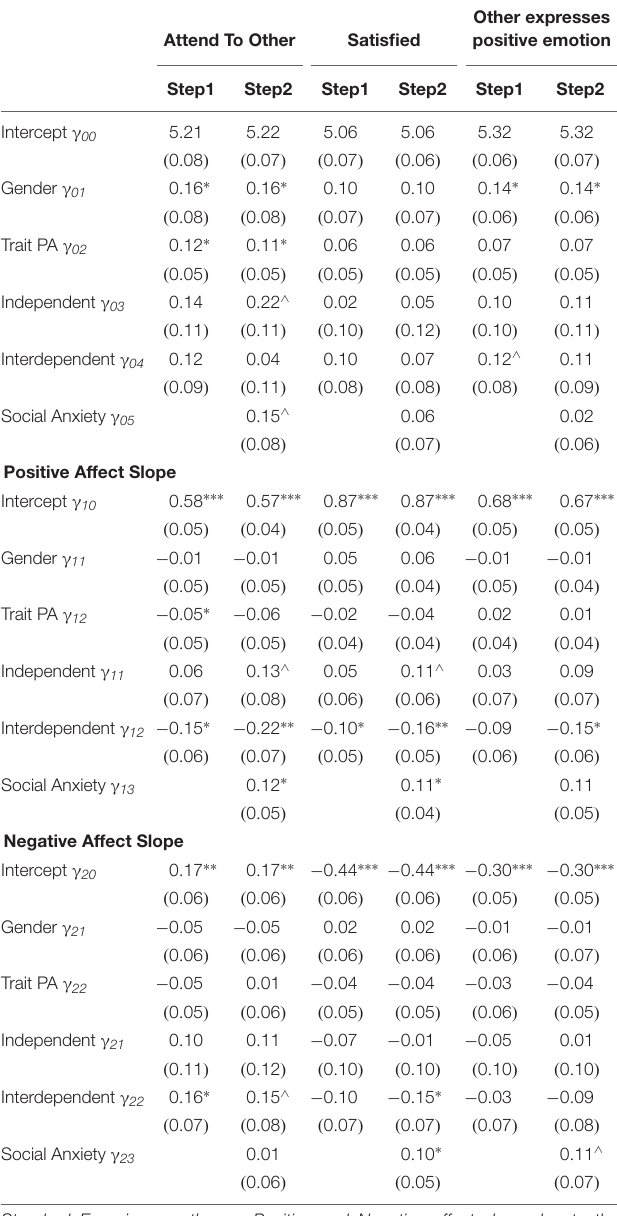
Other expresses